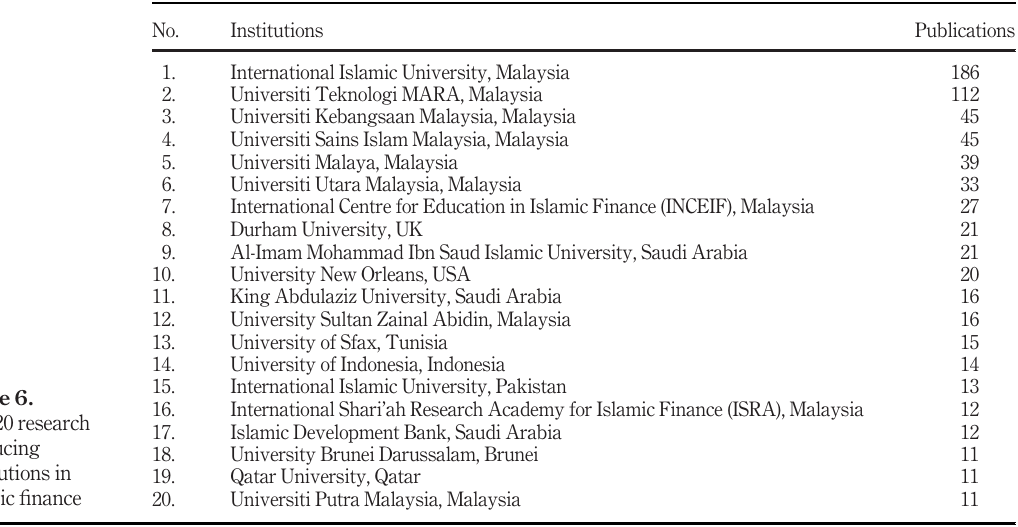
producing institutions in Islamic fi